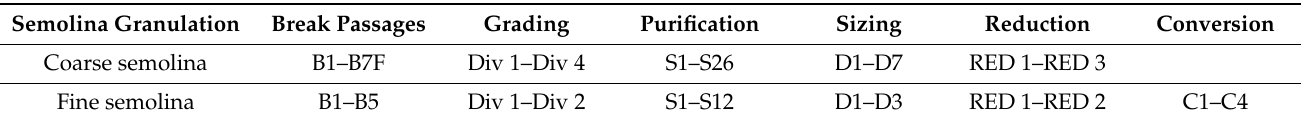
Table 4. Milling passages for coarse and fine semolina production.